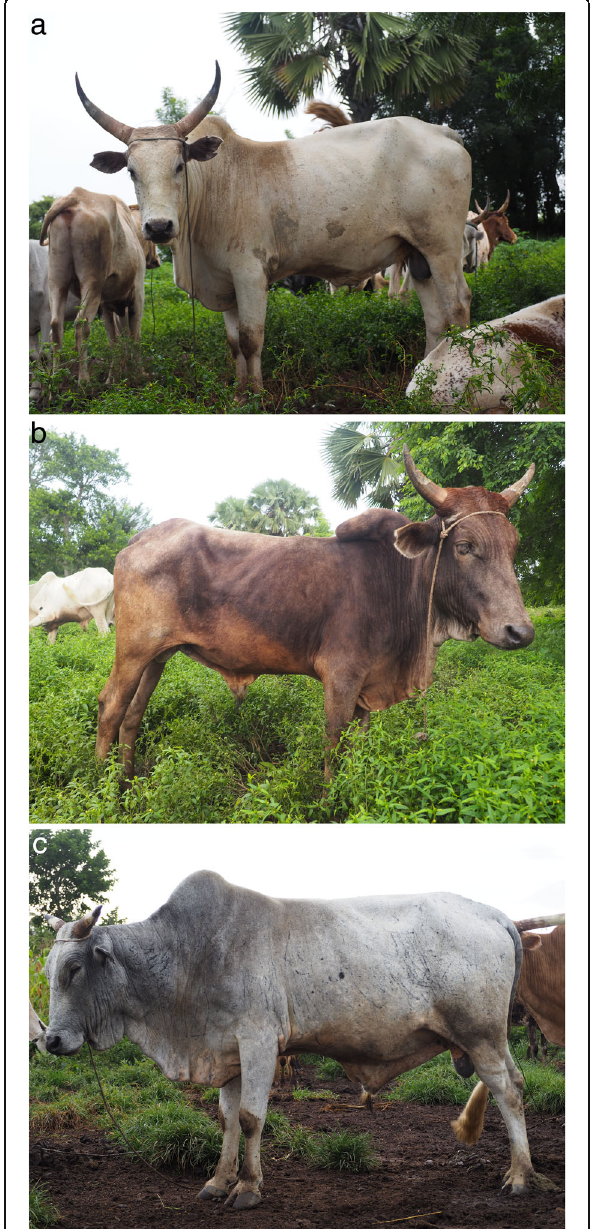
Fig. 3 Examples of Zebu and cross-breeds observed in entrusted herds. a White Fulani bull. b Zebu Azawak. c Goudali